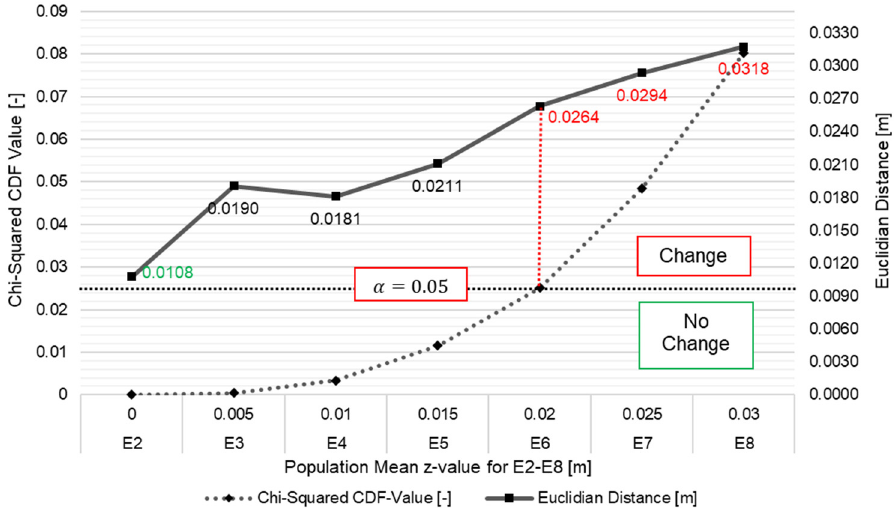
Figure 7. Results of the SDS1 test showing the exponential increase of the Chi-Squared CDF-value vs. the linearly increasing Euclidean distance.